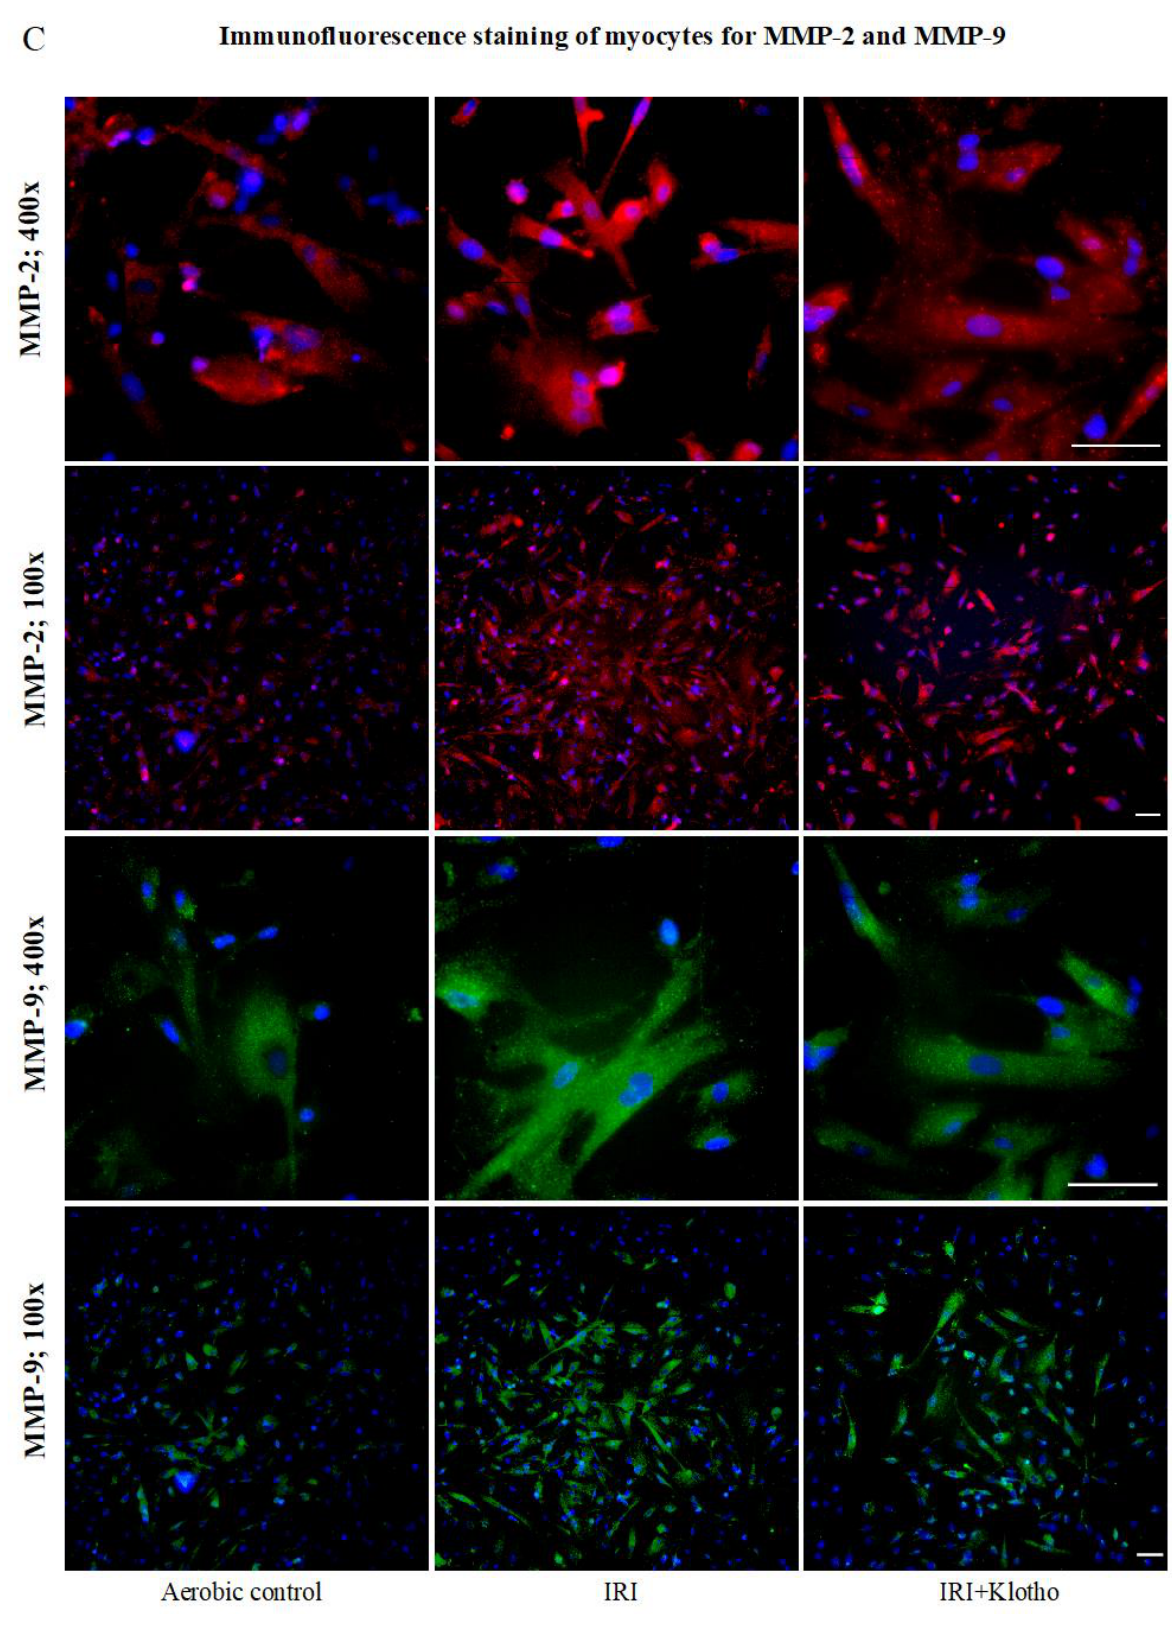
Figure 3. ( A ) Expression of the MMP-2 protein in human cardiomyocytes; n aerobic = 7; n IRI = 7; n IRI+Klotho = 7; ( B ) Expression of the MMP-9 protein in human cardiomyocytes; n aerobic = 7; n IRI = 7; n IRI+Klotho = 7. The expression of the MMP proteins was assessed by immunofluorescence